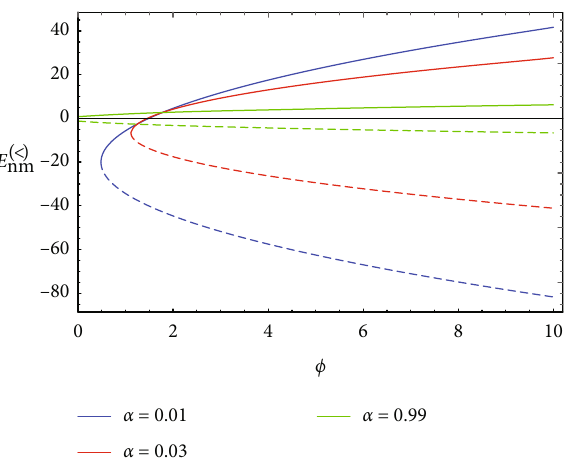
Figure 3: Sketch of the energy (Equation (71)) as a function of ϕ for n = 1 , m = 1 , B = 2 , a = 0 : 1 , and di ff erent values of α . When α approaches 1 , the energy is permissible for all values of ϕ > 0 . For small values of α , the energy is permissible only from a threshold value of ϕ . For α = 0 : 01 (blue line) and α = 0 : 03 (red line), these threshold values are ϕ = 0 : 50 and α = 1 : 12 ,